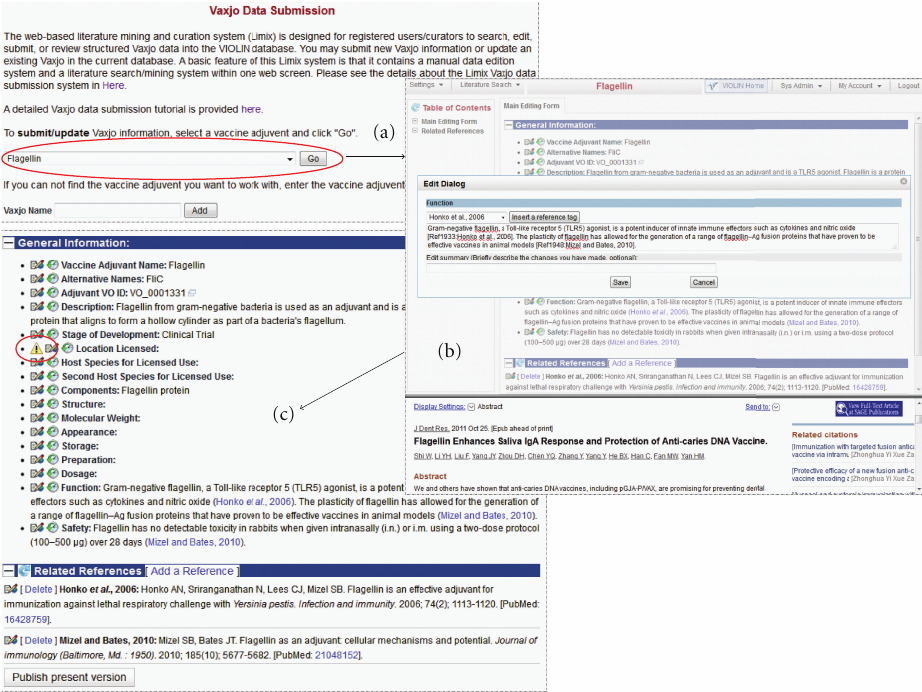
Figure 2: Submission and review processes of vaccine adjuvants into Vaxjo. (a) Selecting an adjuvant from a dropdown list or adding a new adjuvant by entering the name in the field below the dropdown list. (b) Vaxjo submission page, where each section is edited via a popup dialog box that also provides options to insert references when needed. The bottom section of the Vaxjo curation web page includes detailed reference information for a curator to review. (c) Review page. Vaxjo curators review information curated into Vaxjo and, after review, submit the page for publication in